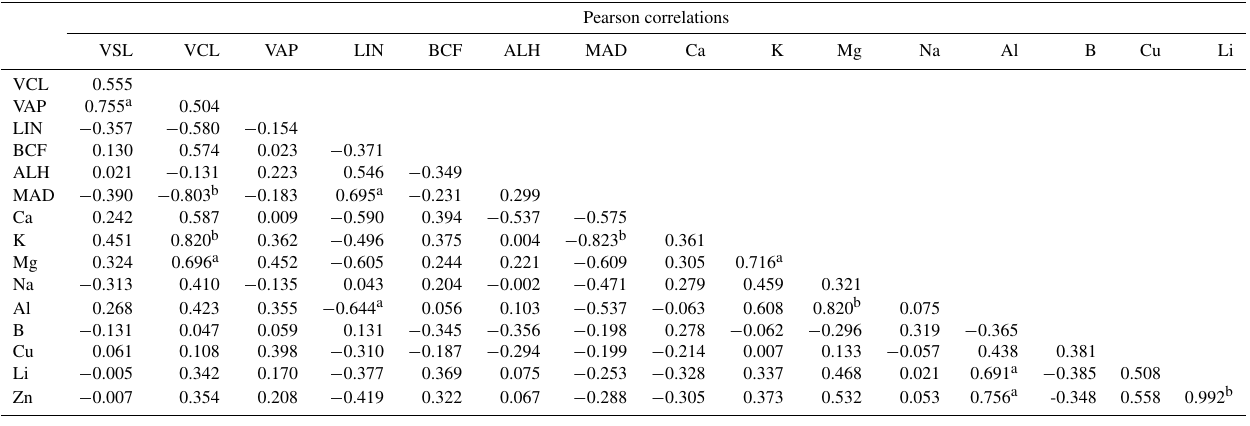
Table 2. Pearson correlations between sperm cell motility and semen seminal plasma contents of Capoeta trutta .